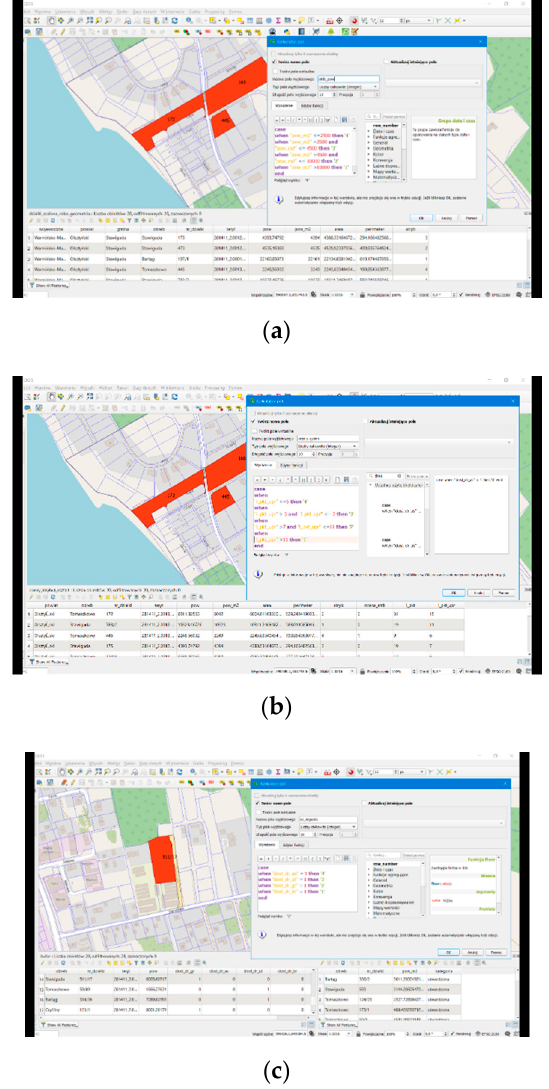
Figure 5. SQL query attributing ratings to real estate according to the adopted rating scale for the ( a ) X area (plot area), ( b ) X access (access to the plot) and ( c ) X shape (number of border points/shape of plots), attributes. Source: own study.